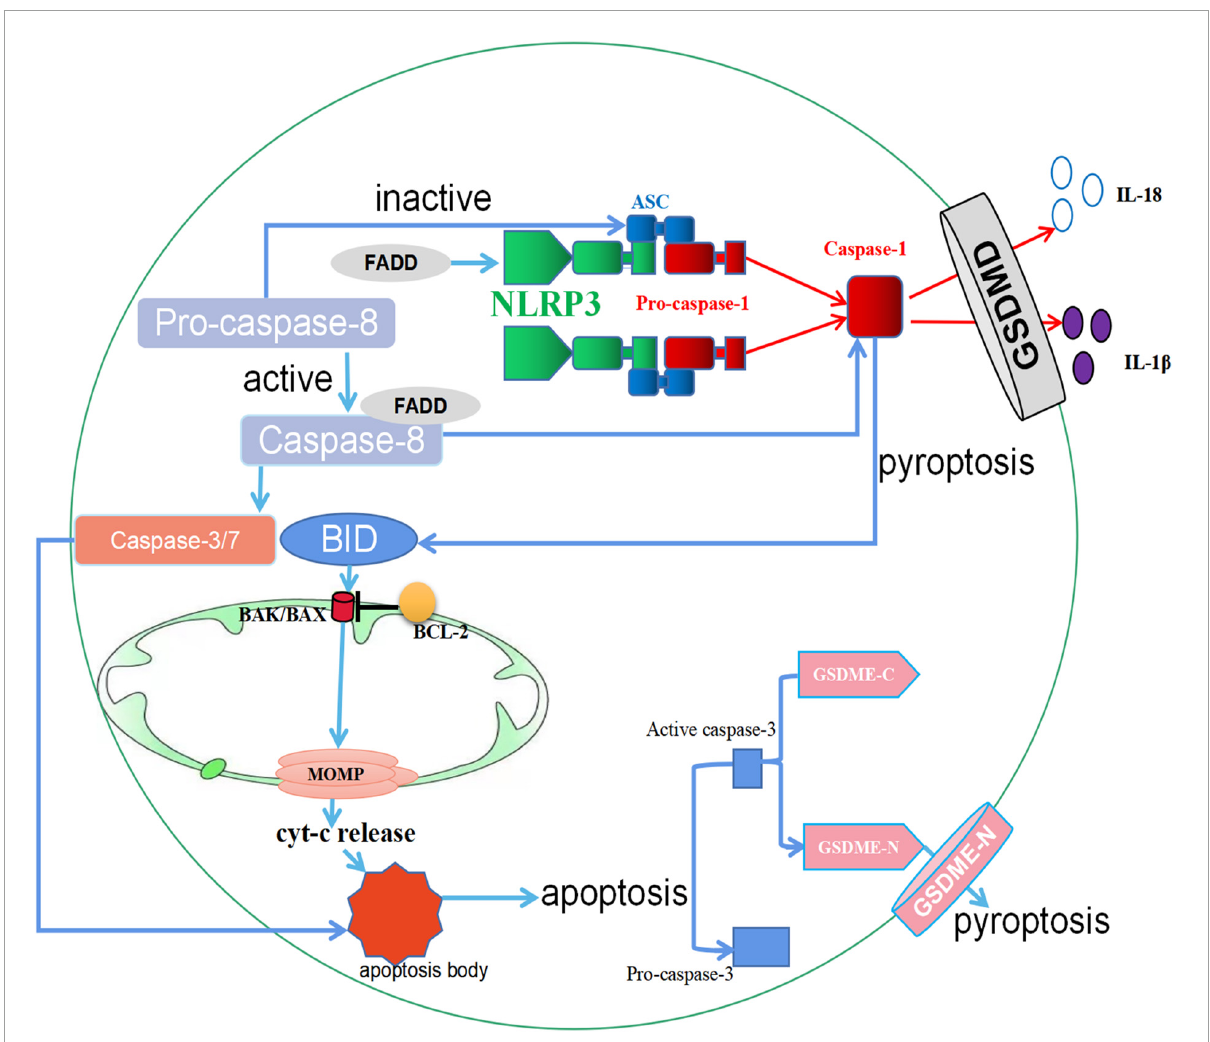
FIGURE3 The crosstalk between apoptosis and pyroptosis. (1) When GSDMD is expressed, Caspase-1 protein is activated, and the activated Caspase-1 protein cleaves GSDMD and eventually leads to pyroptosis. However, in the absence of GSDMD in macrophages, activated Caspase-1 protein can cleave BID, leading to the activation of MOMP, the release of Cyt-c, and downstream apoptotic signaling. In cells where GSDME is present, apoptosis promotes Caspase-3 cleavage of GSDME, ultimately leading to pyroptosis. (2) FADD activates both NLRP3 and Caspase-1 proteins